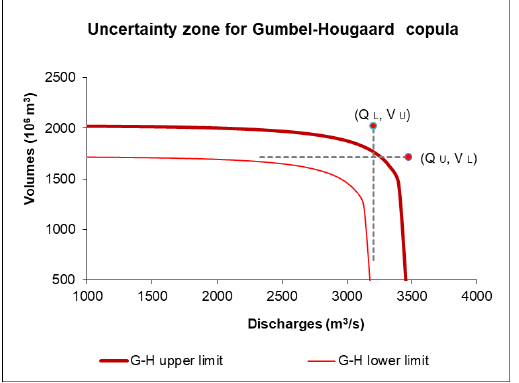
Figure 11. Uncertainty zone, 𝑃% = 1% (Rădăuți -Prut gauge station).